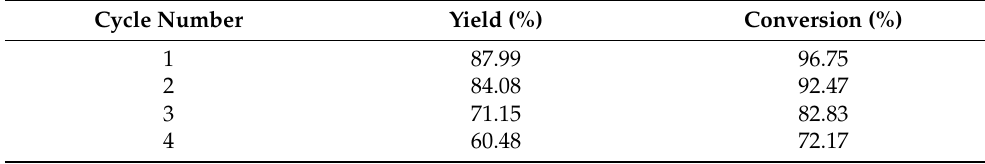
Table 4. Catalyst reusability